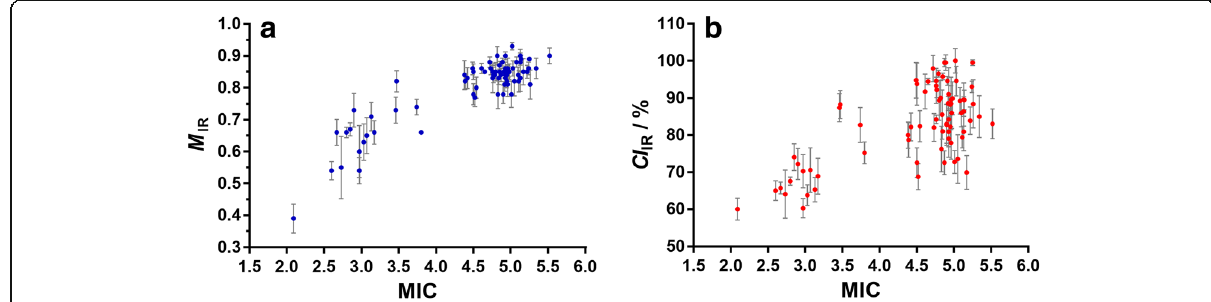
Fig. 5 Comparisons of FT-IR fiber properties with MIC values. ATR FT-IR spectra were measured from the second set of F 2 population composed of various MIC values. M IR ( a ) and CI IR ( b ) values were determined by algorithms and compared with the corresponding MIC values. The correlation coefficient values ( r ) and R 2 values were determined by GraphPad Prisim software. Statistical significance was shown at the probability ( P ) levels value under 0.05*, 0.01**, 0.001***, and